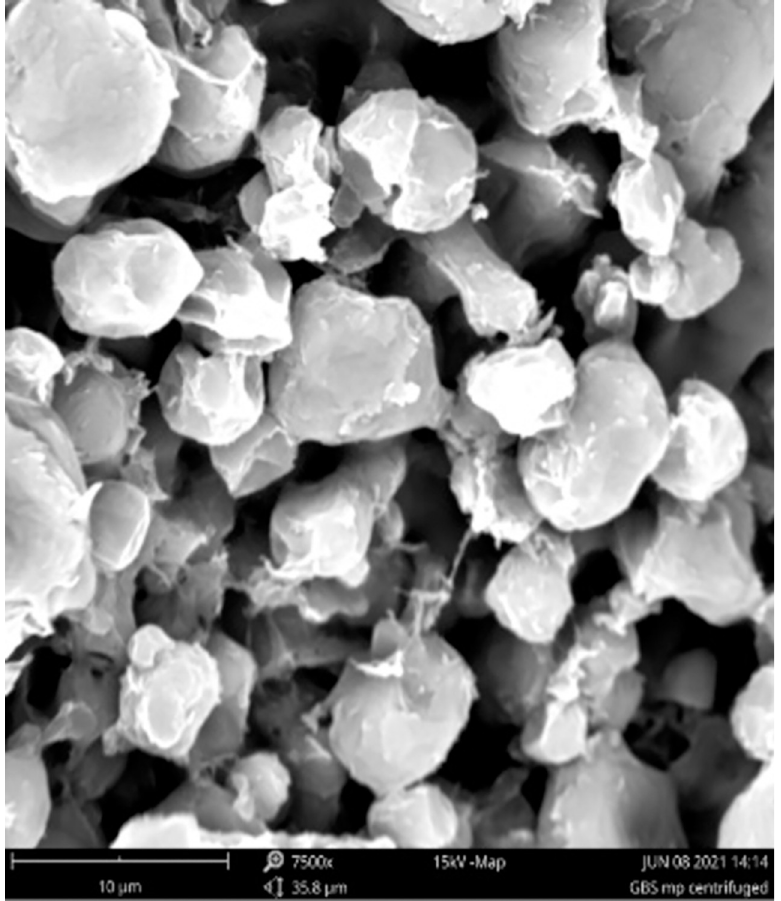
Fig 4. Scanning electron micrograph of GBS-loaded Eudragit E100 microparticles after freeze-drying. Scale bar indicates 10 μ m.